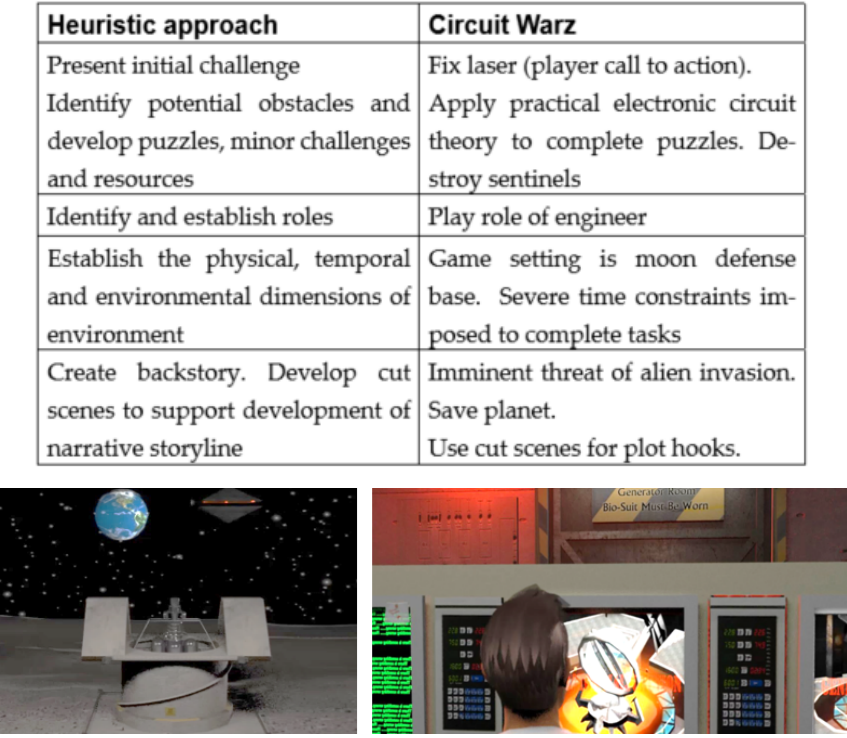
Fig. 6. Heuristic approach Circuit Warz with laser defense facility and faulty generator The mapping of the learning objectives and outcomes to game mechanics involved establishing the game context using a backstory (cut-scenes) which defined the learn- er’s objectives and rationale for subsequent actions (Fig.7). A tutorial introduced the learner to the core mechanics where they became familiar with the controls and user interface. The core loop of the game (across each of the seven levels) involves solving increasingly difficult circuit problems in stages, where the learner explores each level, tries to understand its purpose (cascading information) and how to efficiently solve the problem (strategy) using a simulate/response approach to observe, experiment and analyze circuit behavior under time constraints. This was facilitated by dynamically changing the value(s) of the target output responses of the circuit and ensures that the learner has to fully understand and practically apply the underlying circuit theory to successfully complete each level at each attempt. The end of each level provides feedback to the player on their progress (score